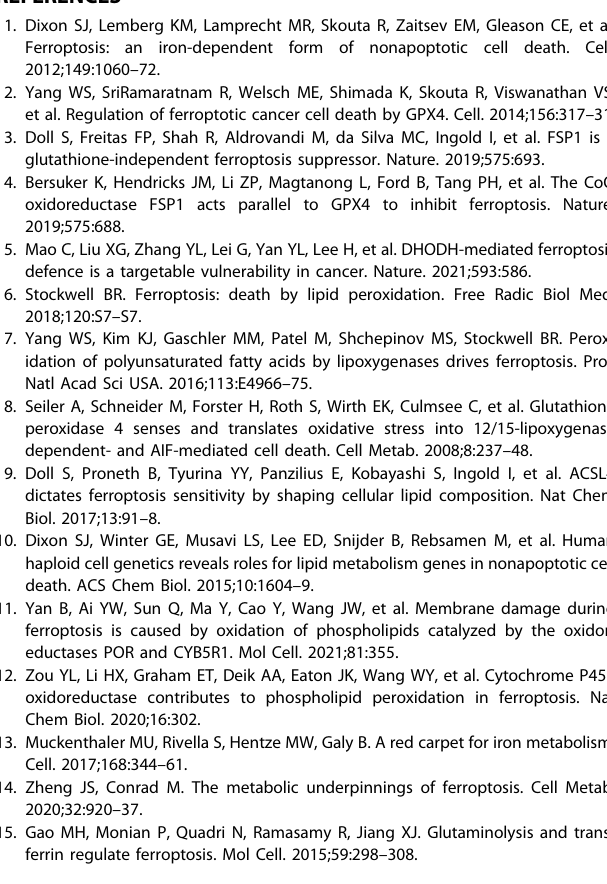
Fig. 6 Schematic diagram deciphering the effect of GSK-3 β on ferroptosis. In the presence of GSK-3 β (left half), erastin activates degradation of beta-catenin and enhances the transcription of iron uptake, transportation, and storage genes (DMT1, FTH1, and FTL), which leads to an increase in cellular iron concentration. Iron overload results in lipid peroxidation and eventually exerts ferroptosis. In the absence of GSK-3 β (right half), erastin-induced ferroptosis is restrained through beta-catenin elevation, and dysregulation of iron metabolism-associated protein (DMT1, FTH1, and FTL), thus cellular labile iron pool is depleted. Decreased intracellular total iron levels and lipid peroxidation further limits erastin-induced